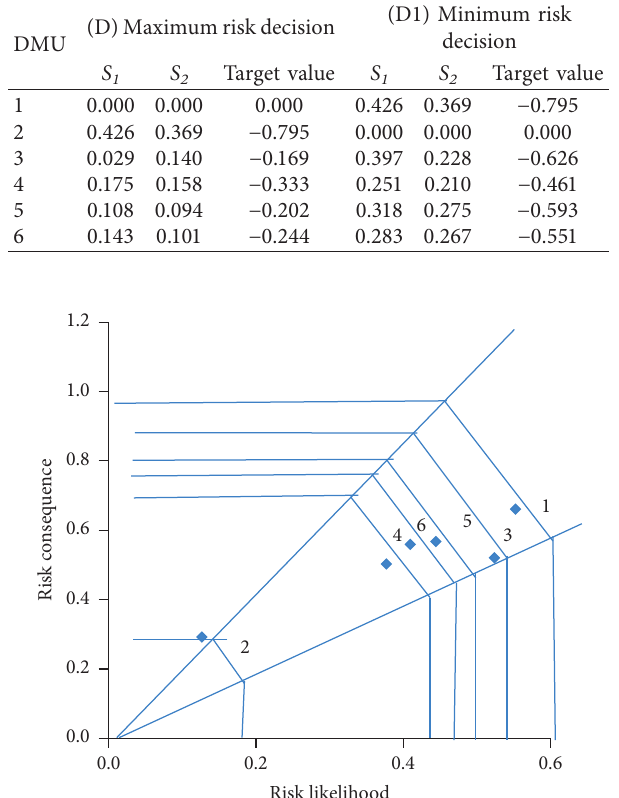
Figure 1: Risk surface distribution diagram of risk DMU.